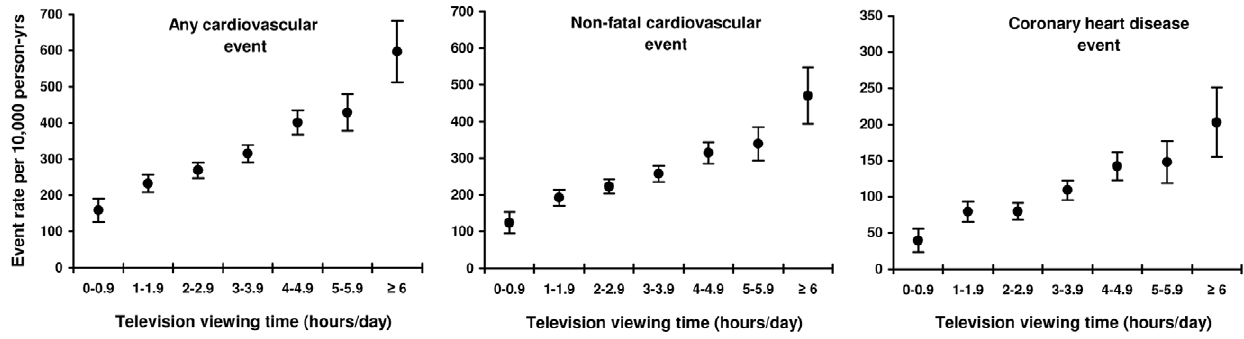
Figure 1. Age-adjusted cardiovascular disease event rates per 10,000 person-years by 1-hour increments of television viewing (hours/day). N television categories: 0–0.99: 800; 1–1.99: 2,126; 2–2.99: 3,180; 3–3.99: 3,057; 4–4.99: 2,040; 5–5.99: 926; $ 6: 479.